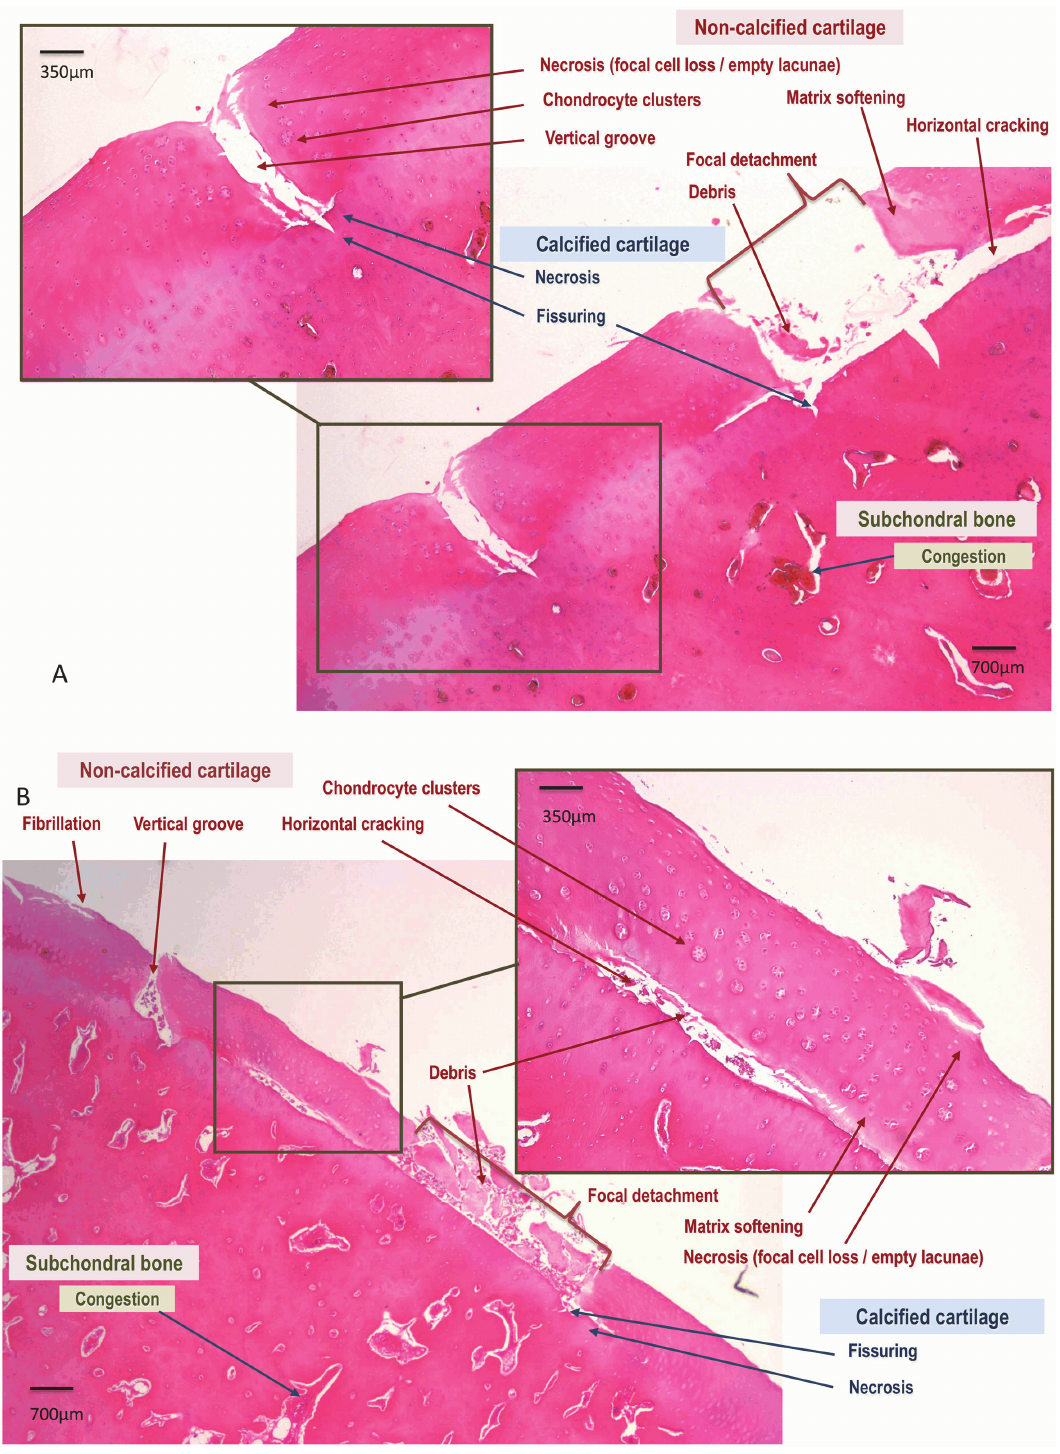
Figure 5. (A and B) Representative light micrographs of the dorsal MC3 condylar cartilage (hematoxylin and eosin stained) obtained from a groove joint at week 10 showing lesions of the non-calcified cartilage (red), calcified cartilage (blue), and subchondral bone